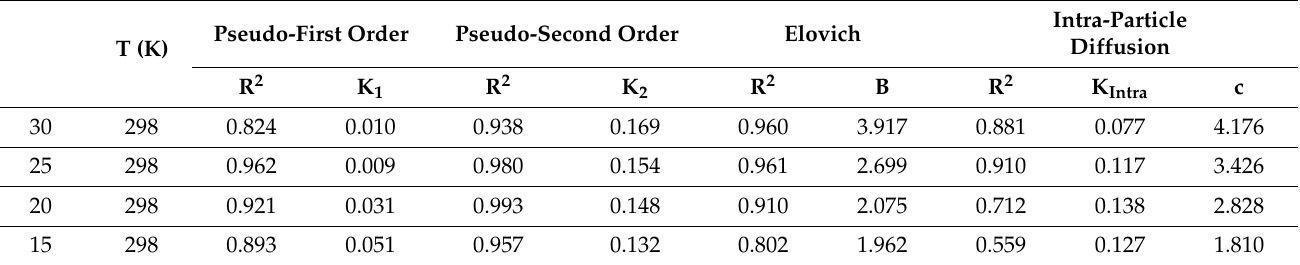
Table 2. Kinetics parameters and correlation coefficients for the